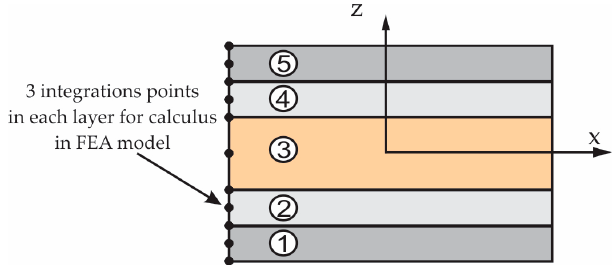
Figure 9. The integration points used for the composite layers of the manhole cover (materials corresponding to the layers 1–5 are shown in Figure 1).